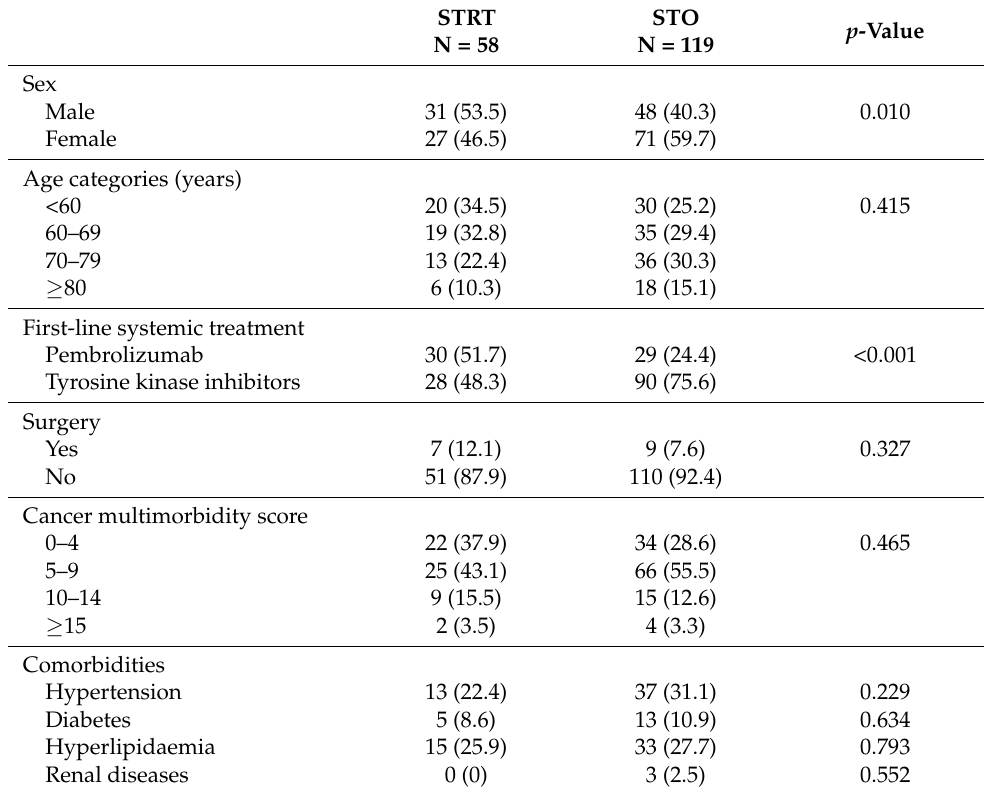
Table 1. Baseline characteristics of 177 patients with advanced NSCLC and brain metastasis in- cluded in the study cohort.